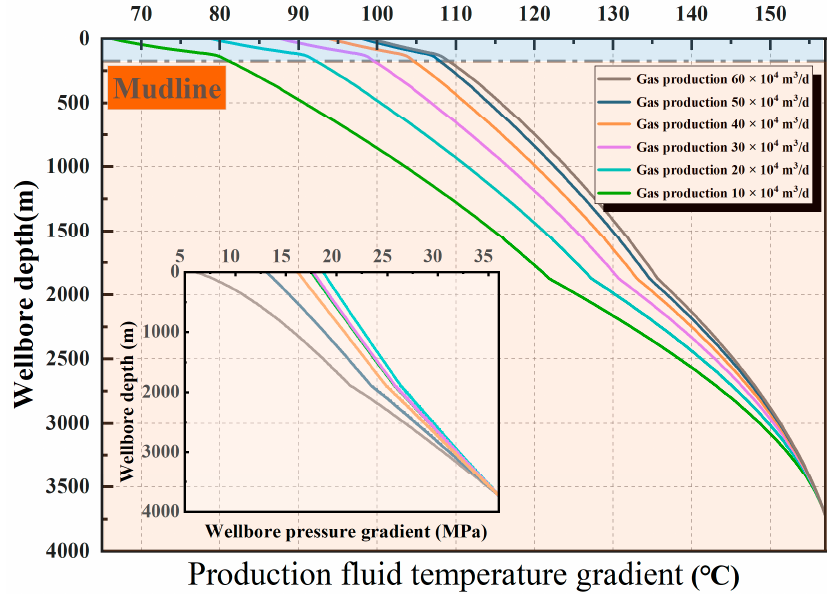
Figure 9. The influence of gas production on wellbore temperature and pressure.